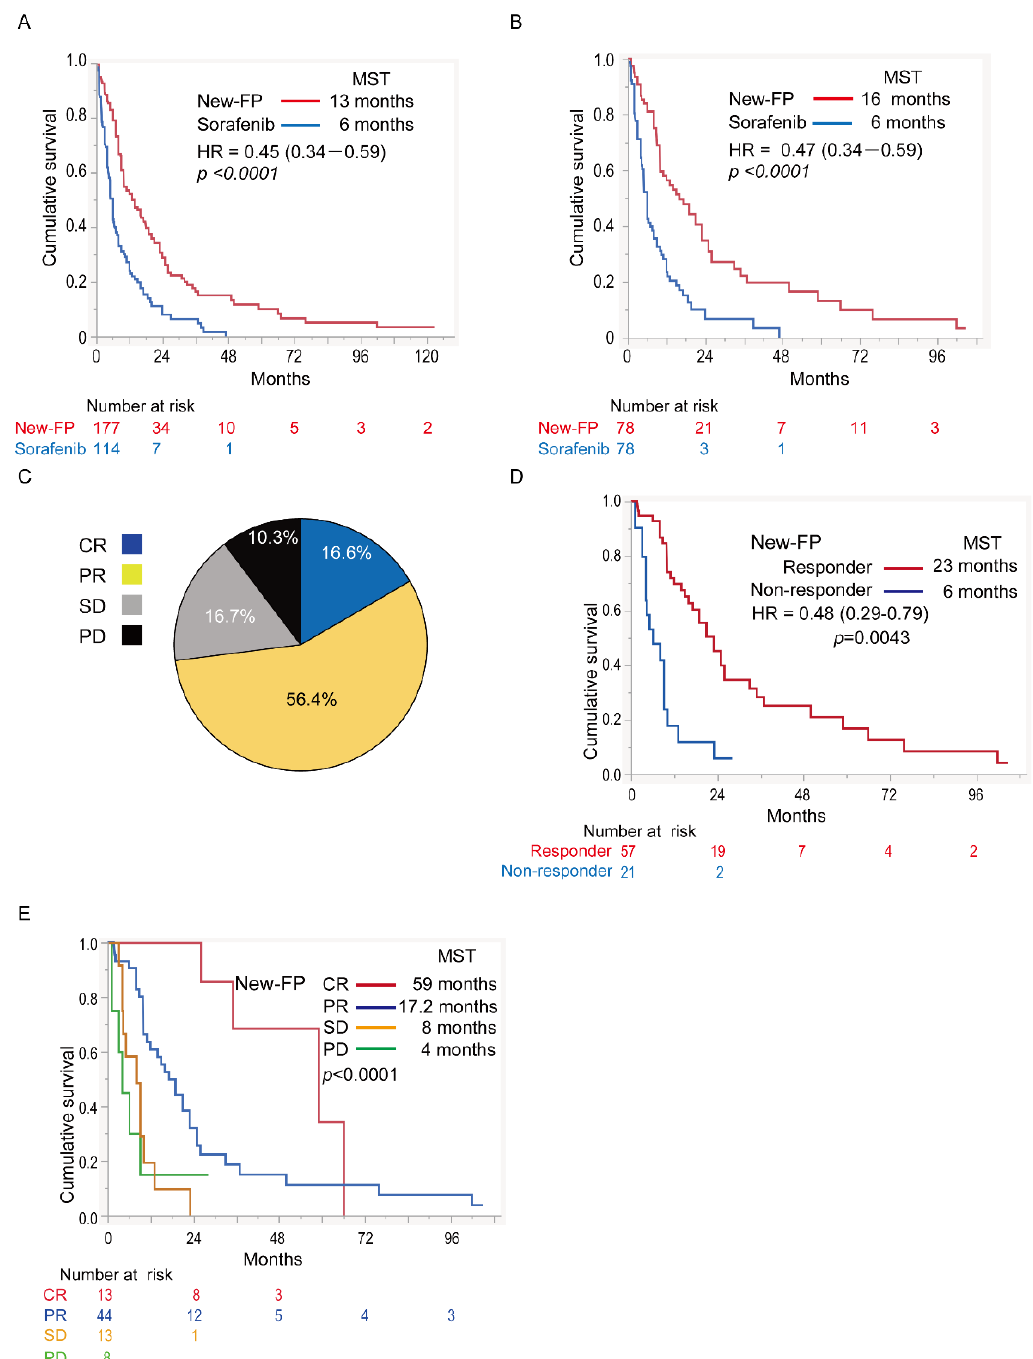
Figure 3. Therapeutic effects of New-FP and sorafenib in HCC with major PVTT. ( A ) Cohort 5, survival curves of patients with major PVTT-HCC before propensity score matching: New-FP ( n = 177, blue line) and sorafenib ( n = 114, red line). ( B ) Cohort 5, survival curves of patients with major PVTT- HCC after propensity score matching: New-FP ( n = 78, blue line) and sorafenib ( n = 78, red line). ( C ) Therapeutic response for New-FP in major PVTT-HCC. ( D ) Survival curves in the responder (red line, n = 57) and non-responder groups (blue line, n = 21) for New-FP. ( E ) Survival curves in different therapeutic response groups for New-FP: CR (red line, n = 13), PR (blue line, n = 44), SD (yellow line, n = 13), and PD (green line, n = 8). CR, complete response; HCC, hepatocellular carcinoma; HR, hazard ratio; MST, median survival time; PD, progressive disease; PR, partial response; PVTT, portal vein tumor thrombus; SD, stable disease.